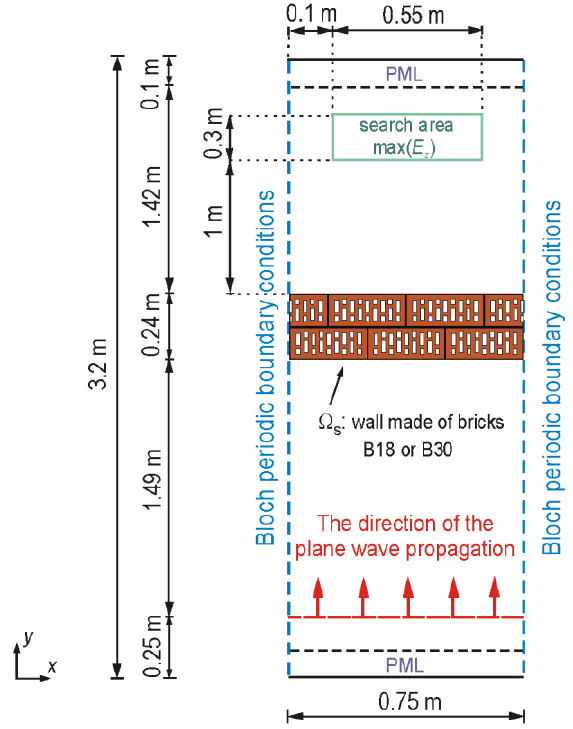
Figure 5. Numerical model used for calculation of systems with the heterogeneous material.